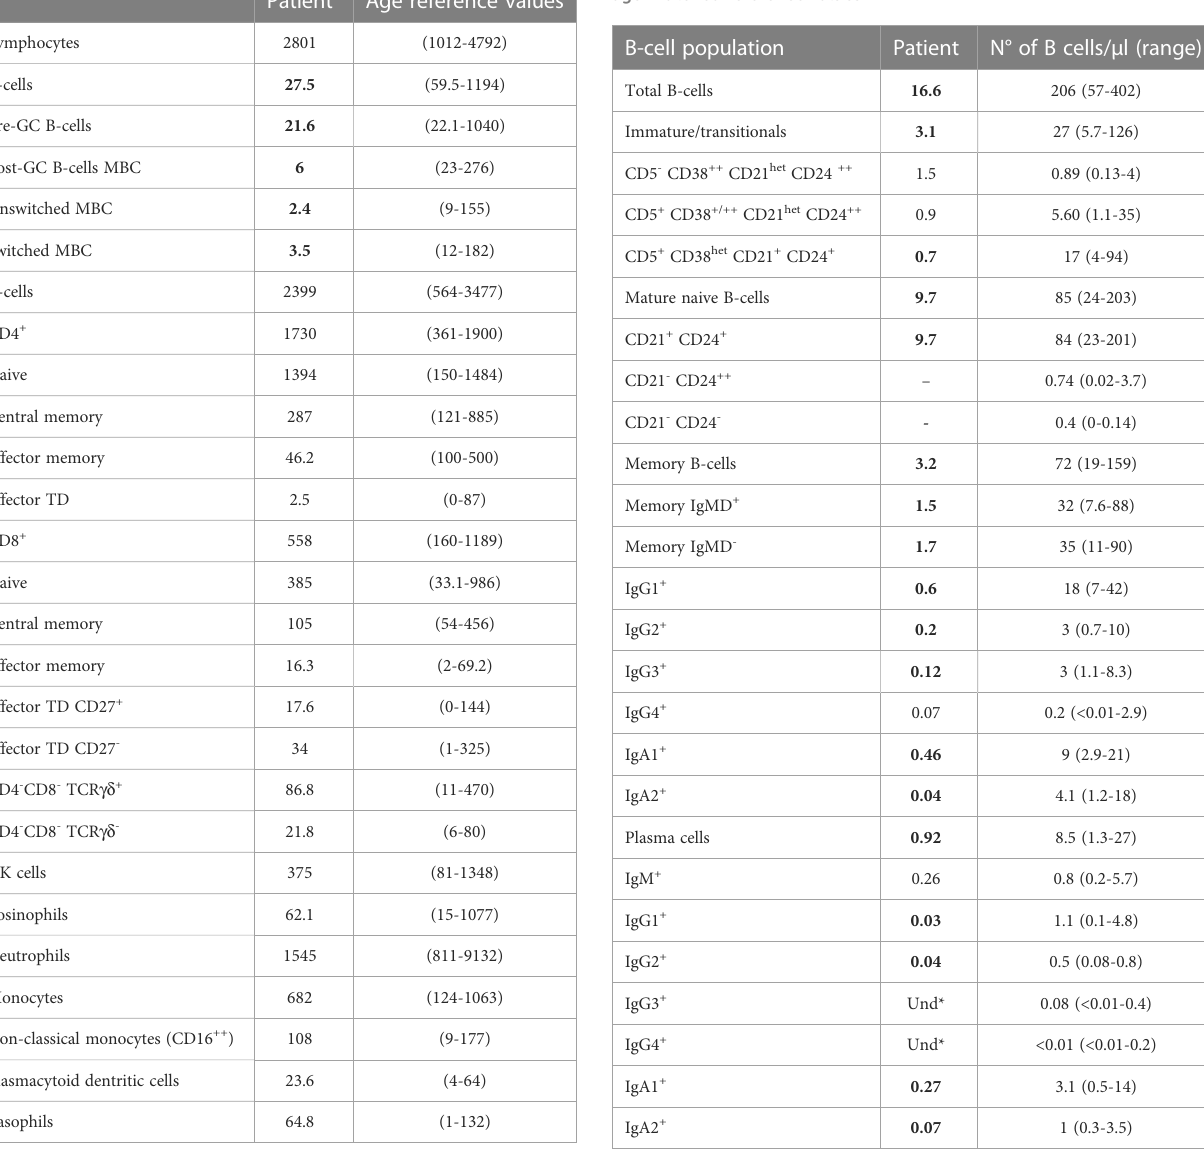
TABLE 2 Distribution of different subsets of blood B-cells, including MBC and plasma cells subsets expressing different